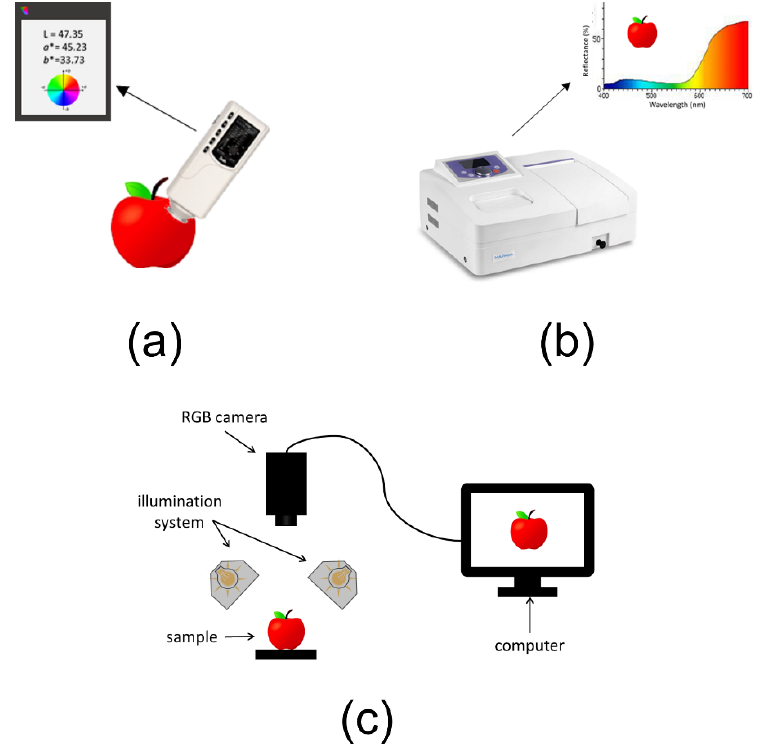
Figure 1. Representation of the different devices used as EE sensors: colorimeter ( a ), spectrophotometer ( b ), and computer vision system ( c ).